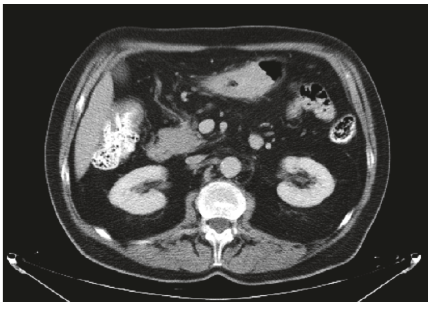
Figure 7: Abdominal CT scan showing stenotic